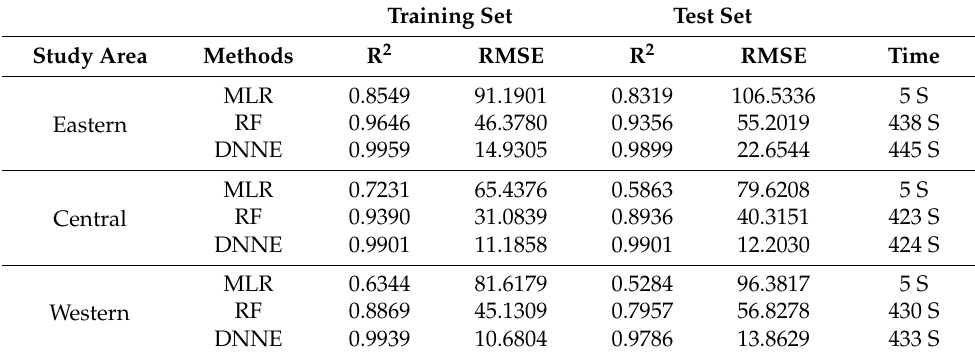
Table 3. Comparison of model results.